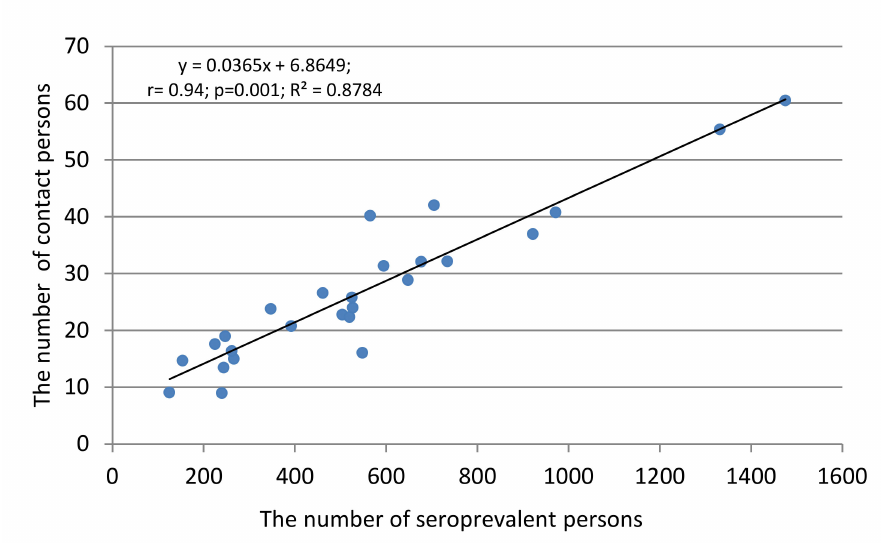
Figure 9. Correlation between the number of seropositive and COVID-19 contacts. The equation, regression, correlation coefficient value (r), the reliability of the relationship ( p ), and the coefficient of determination (R 2 ) are